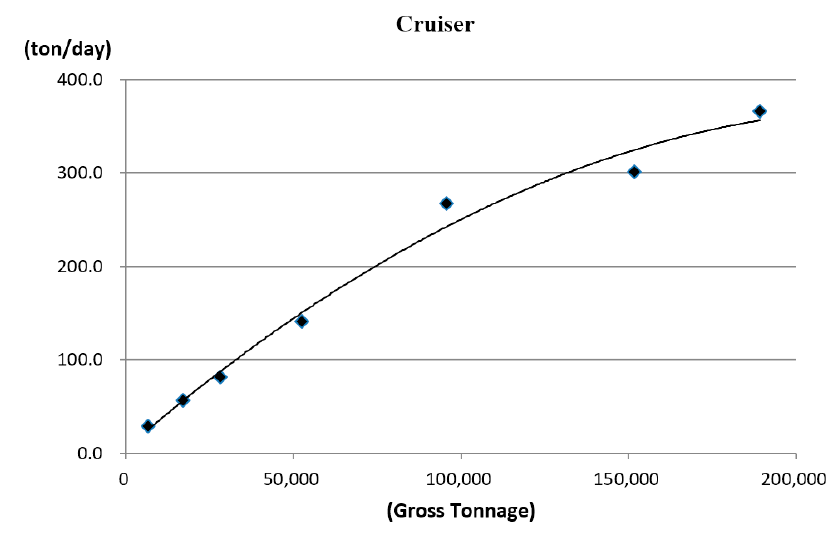
Figure 5. Daily LNG Fuel Consumption of Cruiser.